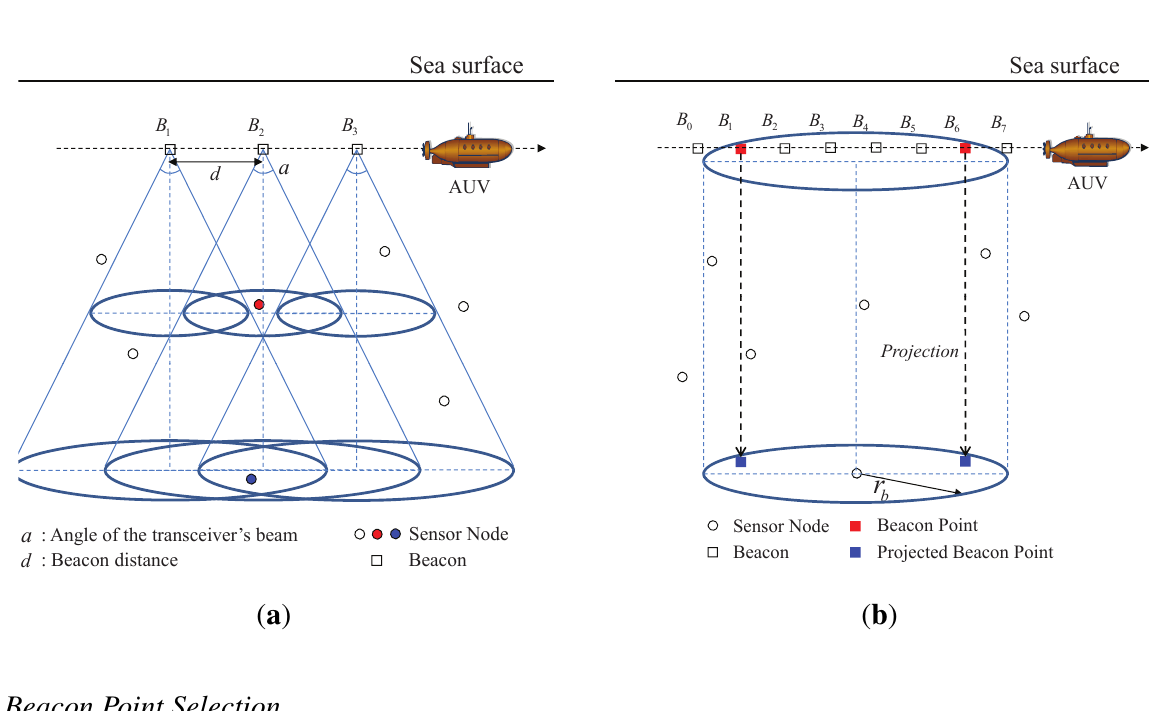
Figure 2. System environment and beacon point selection and projection for